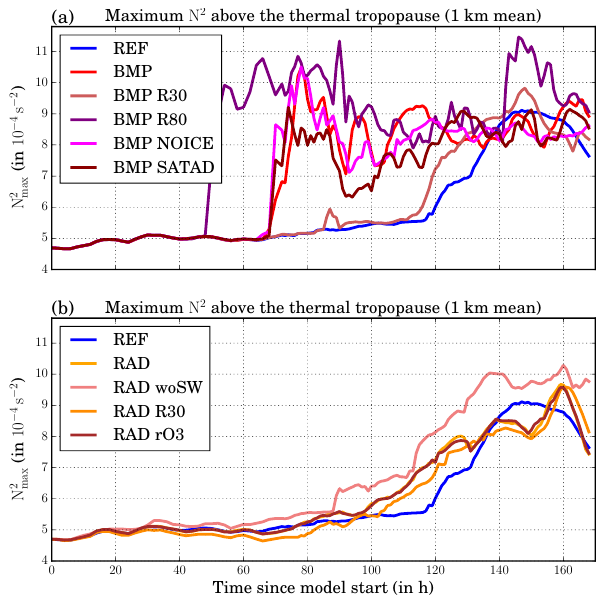
Figure 7. Temporal evolution of the maximum static stability N 2 max (in 10 − 4 s − 2 ) above the thermal tropopause for sensitivity simu- lations of (a) BMP and (b) RAD. In (a) N 2 max is shown for REF (blue), BMP (red), BMP R30 (light red), BMP R80 (purple), BMP NOICE (magenta), and BMP SATAD (dark red). In (b) N 2 max is shown for REF (blue), RAD (orange), RAD woSW (coral), RAD R30 (dark orange), and RAD rO3